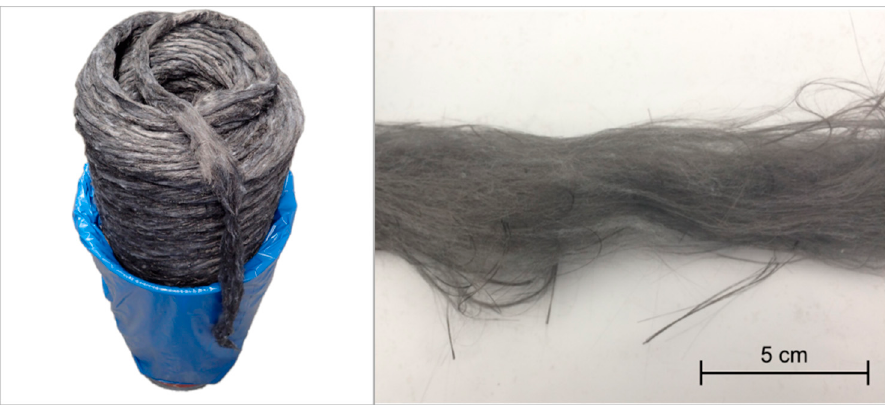
Figure 6. Sliver coil ( left ) and texture of the recycled staple fiber sliver ( right ).